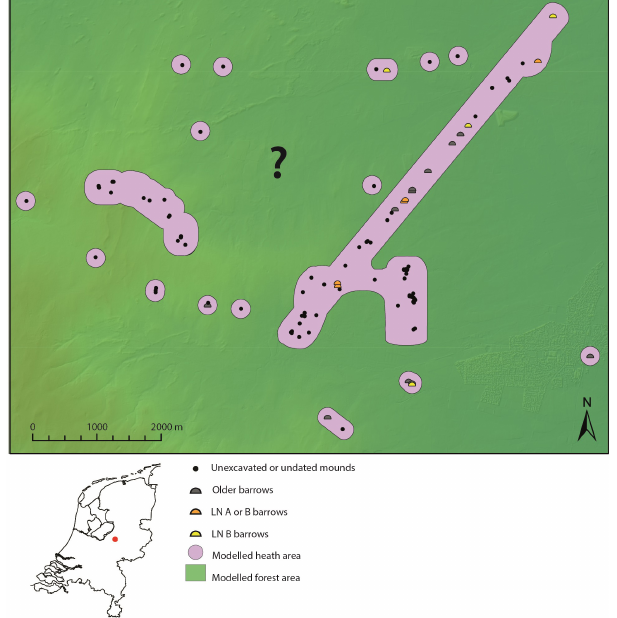
Figure 7. Barrow alignments of Vaassen–Niersen, situated in a (hy- pothetical) long-stretched heath area surrounded by forest. The veg- etation reconstruction is based on palynological data from barrows. An exact reconstruction of the forest area is therefore not possible (indicated by the question mark), since barrows are not present in those areas. The figure is based on the digital elevation model of the AHN ( © www.ahn.nl). Figure after Doorenbosch (2013, Fig. 13.1c).